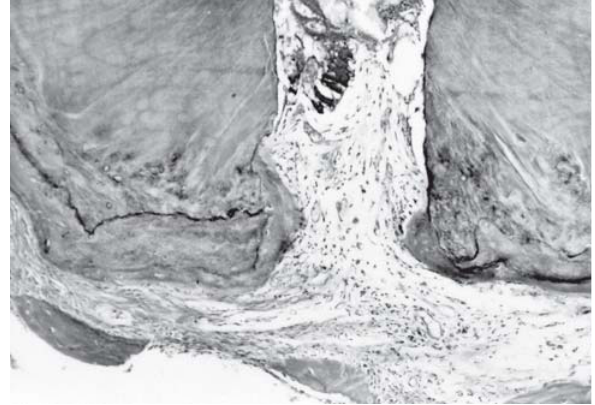
FIGURE 4- Group III – Metronidazole – No biological closure, repair of areas of cemental resorption and periodontal ligament showing few chronic inflammatory cells. H.E.,